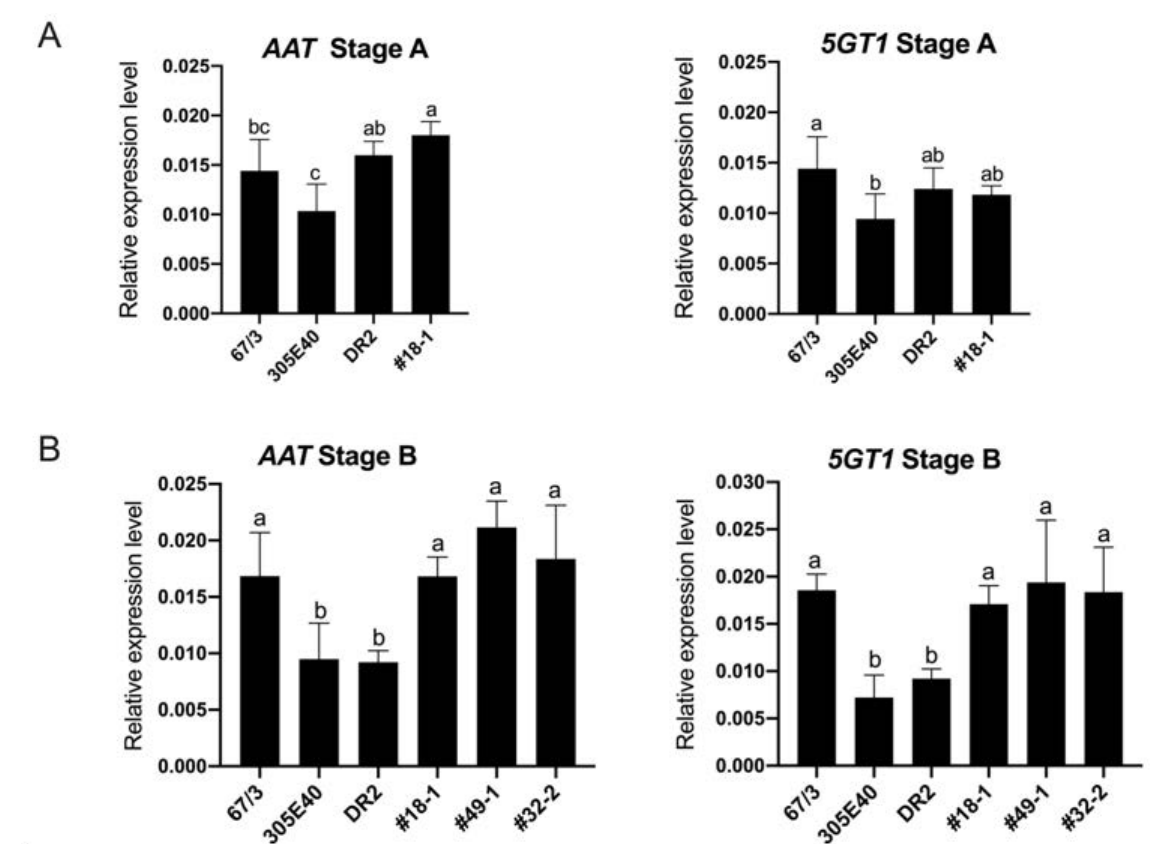
Figure 7. RT-qPCR transcription profiling of SmelAAT and Smel5GT1 in peels at stages A and B of fruit ripening. Expression levels in lines ‘67/3’, ‘305E40’, and ‘DR2’ were compared to those of ‘DR2’ p35S::SmelAAT #18-1 at stage A ( A ) and of transgenic plants ‘DR2’ p35S::SmelAAT #18-1, #49-1, and #32-2 at stage B ( B ). Data are the means of three biological replicates ± SD. Different letters indicate significant differences at p < 0.05 (Tukey’s